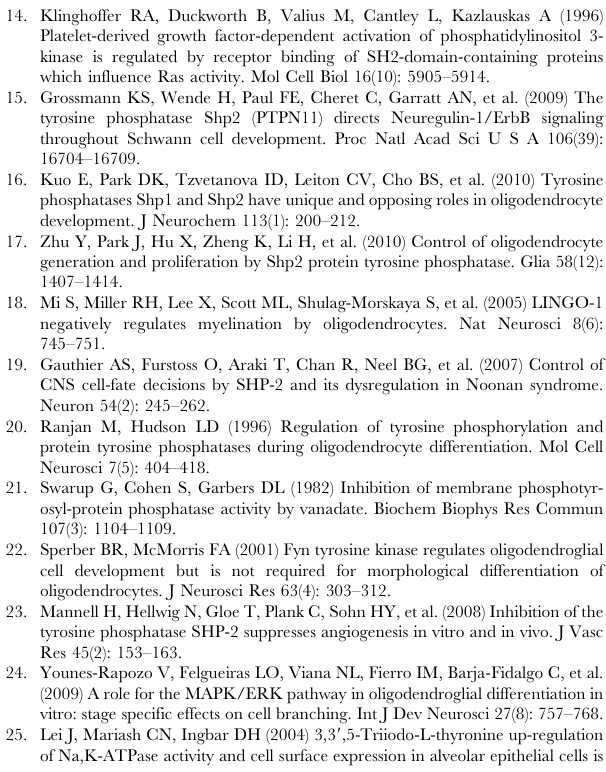
Figure 11. Inhibition activation of Akt and ERK1/2 attenuates the promotional effect of SHP-2 on oligodendrocyte maturation. ( A ) OPCs were infected with lentivirus expressing SHP-2 using blank vector as control. Cultures transfected with SHP-2 were pre-treated with 2.0 m M PD98059 (MEK1/2 inhibitor) or 20 m M LY294002 (PI3K inhibitor) for 30 min, respectively. Cells were immunostained with anti-MBP antibody (red). Arrows indicate MBP + in GFP-expressing cells. The cells infected with Lentivirus expressing the blank vector tagged by GFP were used as control. ( B ) Percentages of MBP-positive cells (red) against the number of infected cells. Over 500 cells were analyzed for each group. Data represent three independent experiments. * p , 0.05 and ** p , 0.01. ( C ) Activation of Akt and ERK1/2 in oligodendrocytes induced by T3 (30 nM) were assessed with western blot after inhibitors pre-treatment. ( D ) Pre-treatment with PD98059 (2.0 m M) or LY294002 (20 m M) did not induce significant OPCs death in cell culture